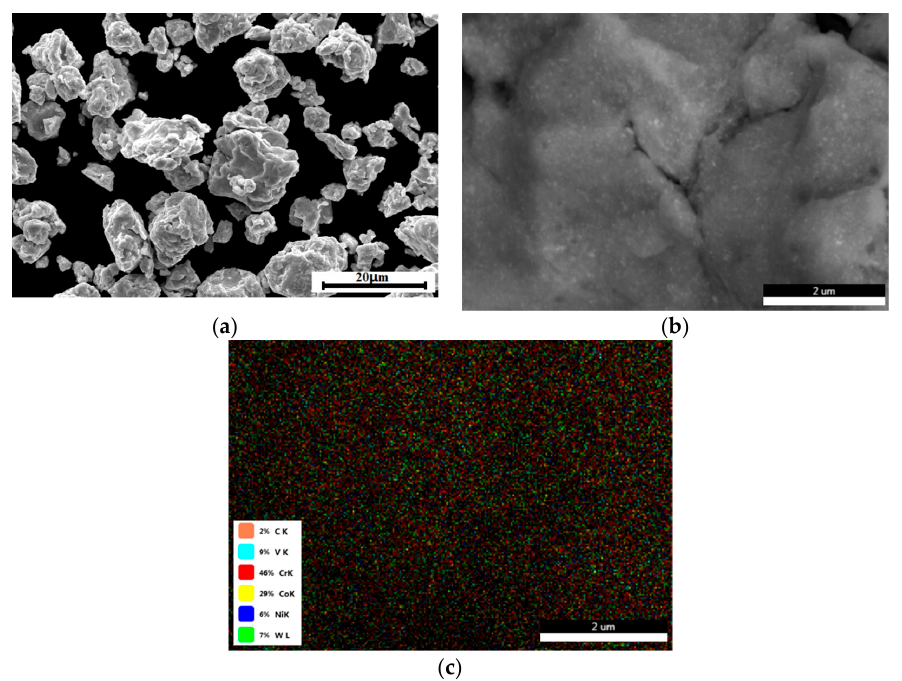
Figure 2. SEM images of the cobalt-based alloy powders after milling for 10 h, ( a ) morphology of the milled powders, ( b ) back-scattered electron (BSE) image of one particle, and ( c ) element mapping image of energy dispersive X-ray spectrometry (EDS)